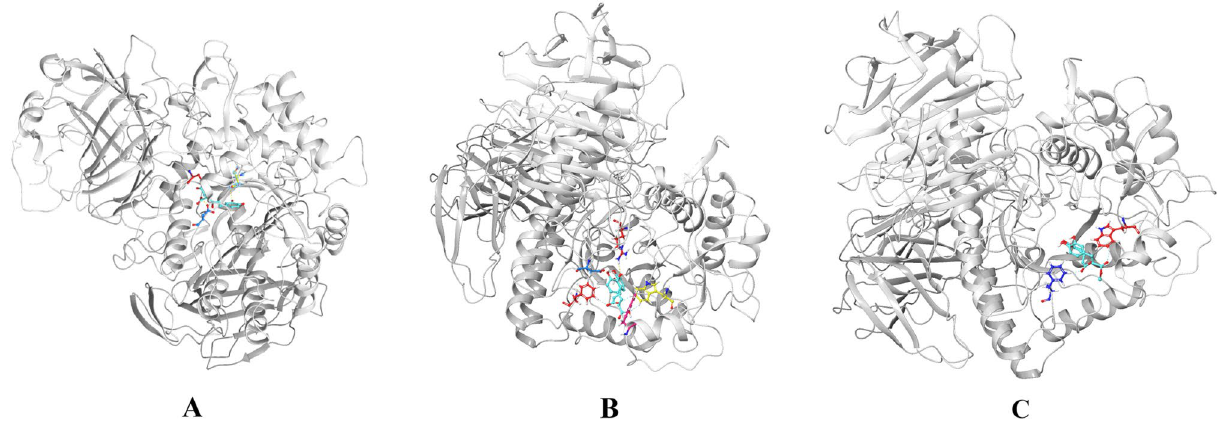
Figure 6. Molecular docking models of α-glycosidase and compounds 1 ( A ), 3 ( B ), and 4 ( C